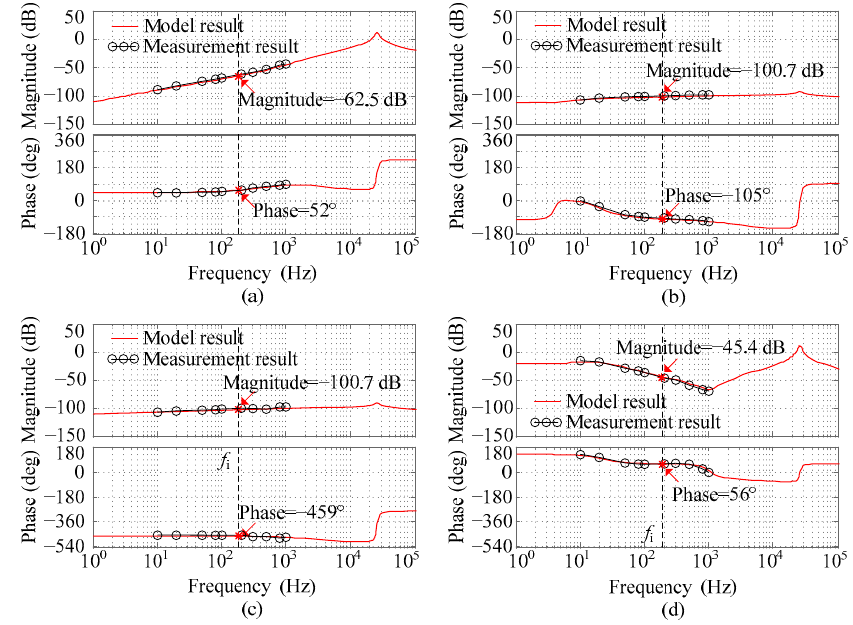
Figure 11. The Bode diagrams of inverter output admittances Y invc_PLL with proposed admittance reshaping technique 1. ( a ) Y cdd ; ( b ) Y cqd ; ( c ) Y cdq ; ( d ) Y cqq .